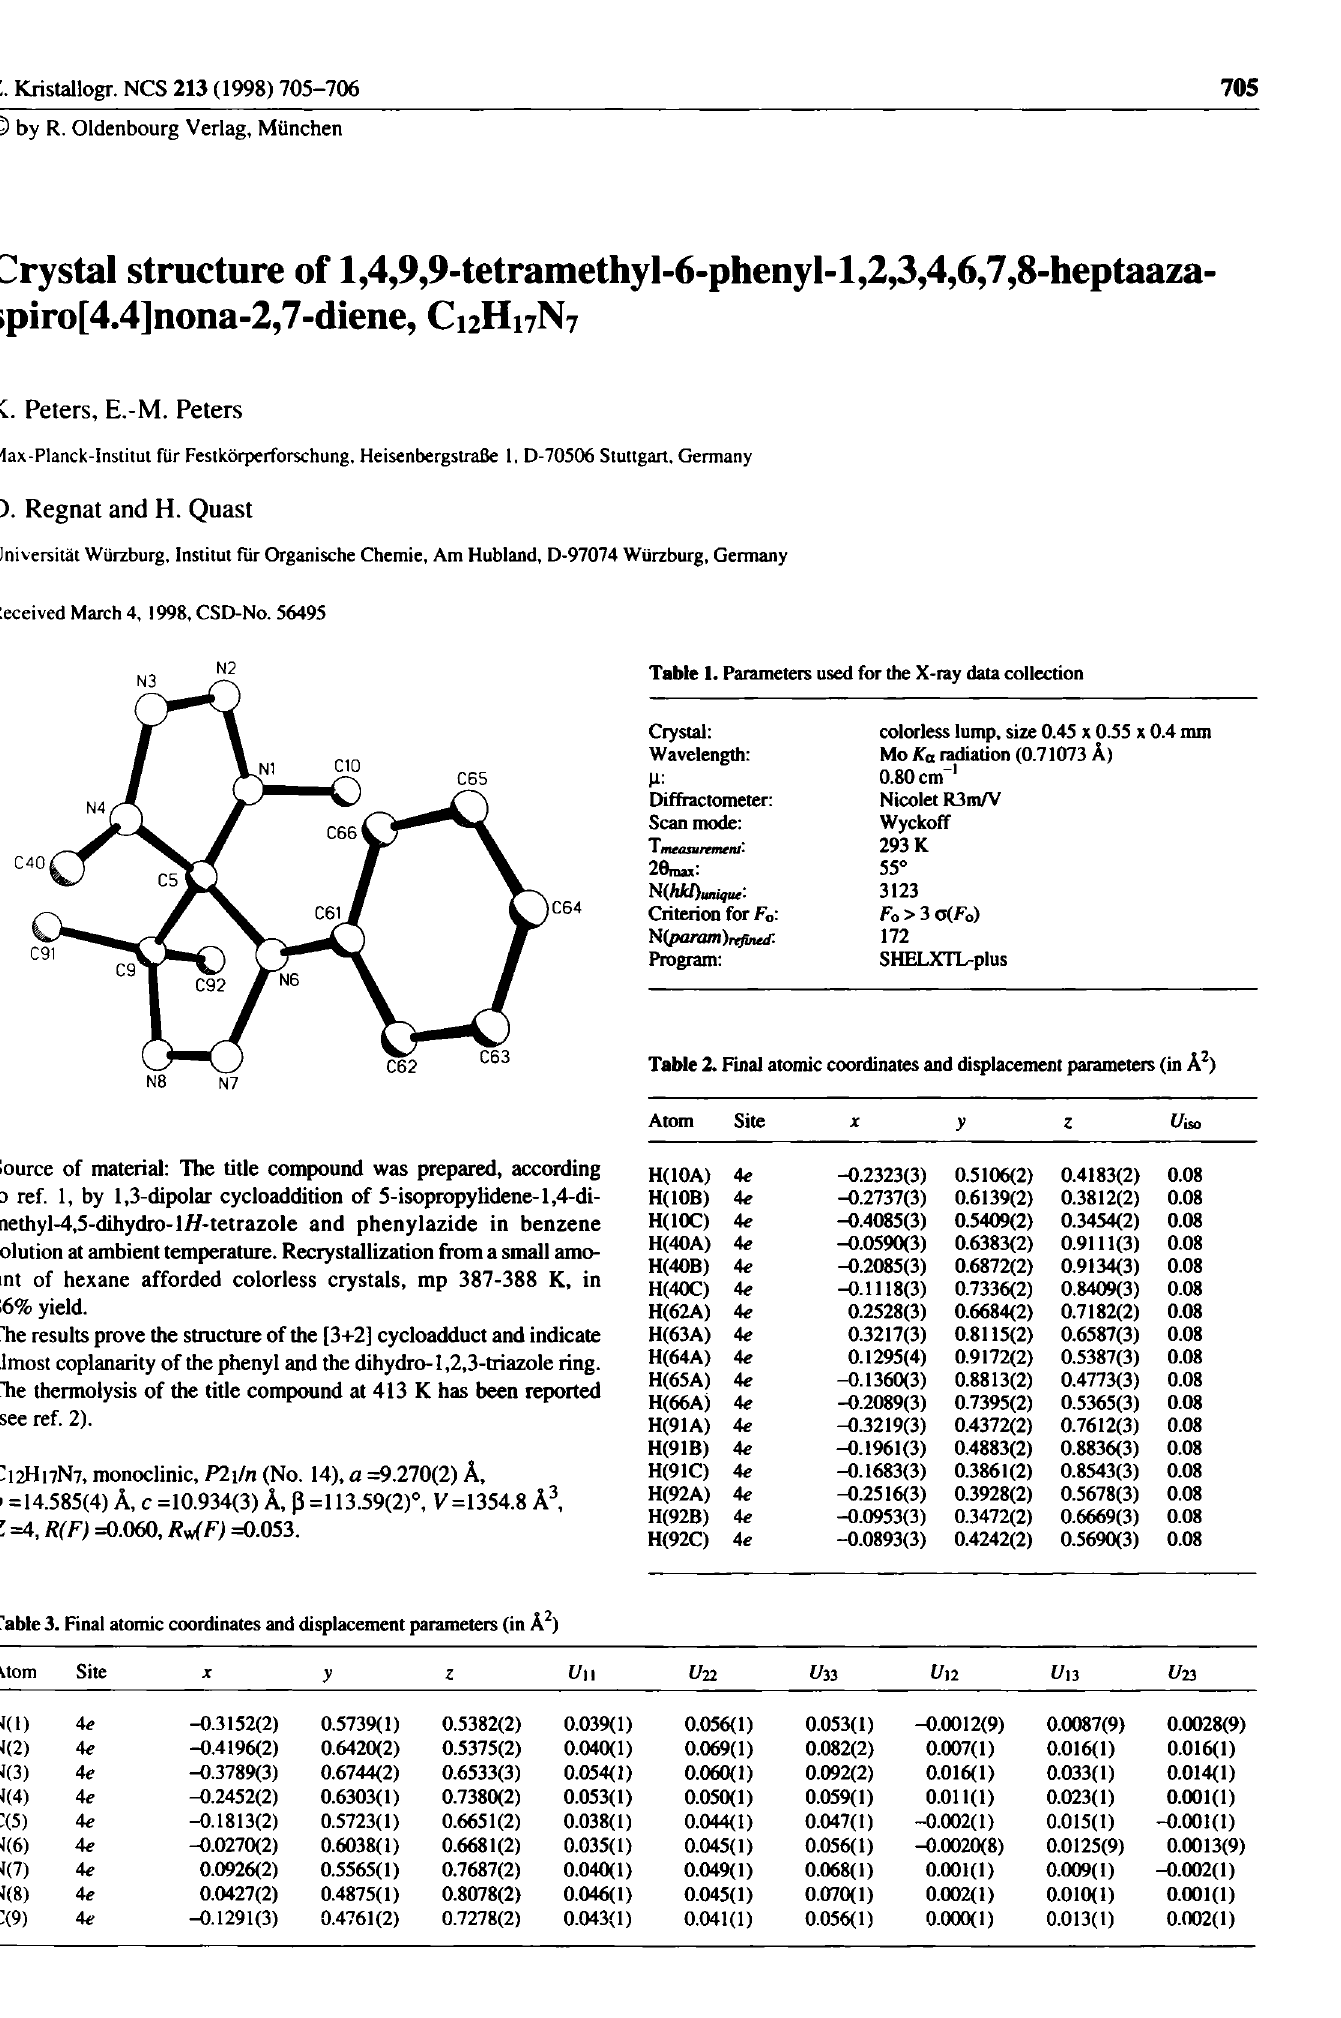
Table 3. Final atomic coordinates and displacement parameters (in Â^)